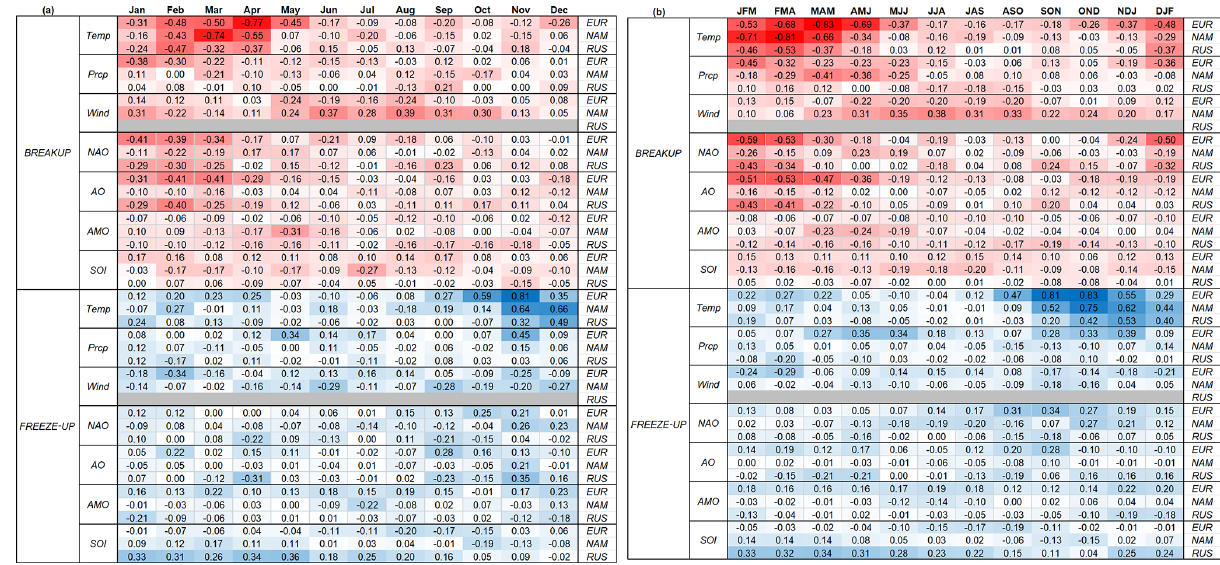
Figure 8. Heat map illustrating correlations between breakup/freeze-up and a series of climatic variables and indices for each of the three study regions – Europe (EUR), North America (NAM), and Russia (RUS) – on a monthly basis (a) and for 3-monthly means (b) , where JFM is the mean of January, February, and March; FMA is the mean of February, March, and April; etc., over the time period 1931–2005. The grey line for Russia displays that there were no wind data